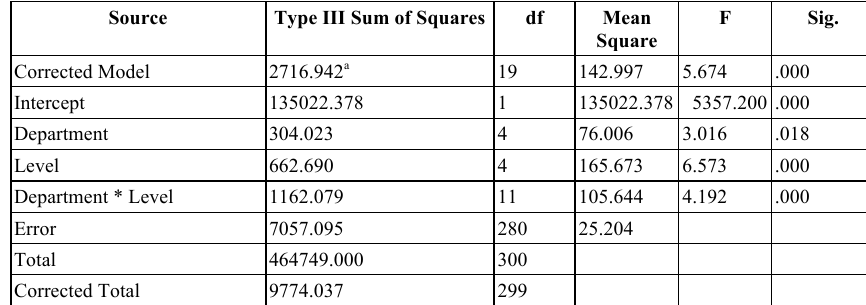
Table 8. Tests of Between-Subjects Effects – Dependent Variable: Readiness_3D